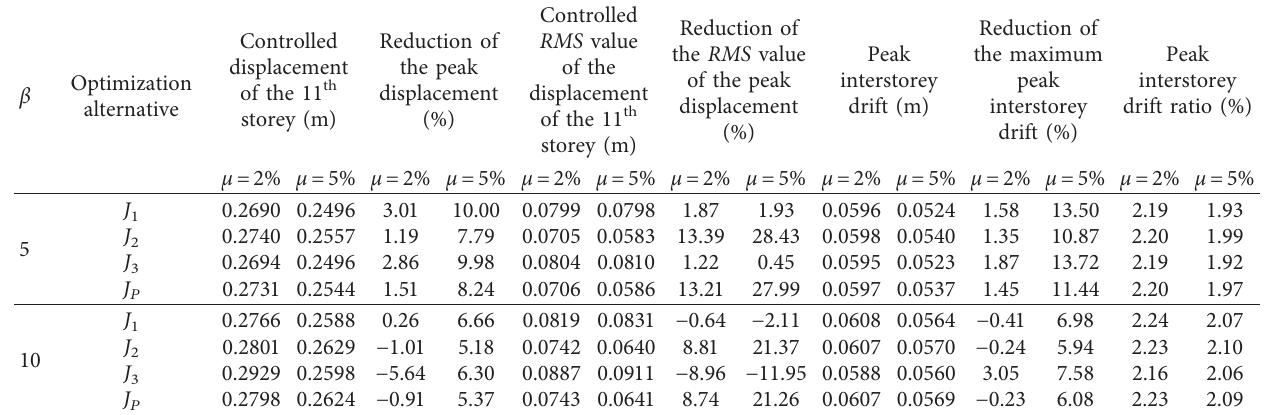
Table 12: Controlled response of the structure subjected to “ Christchurch ”